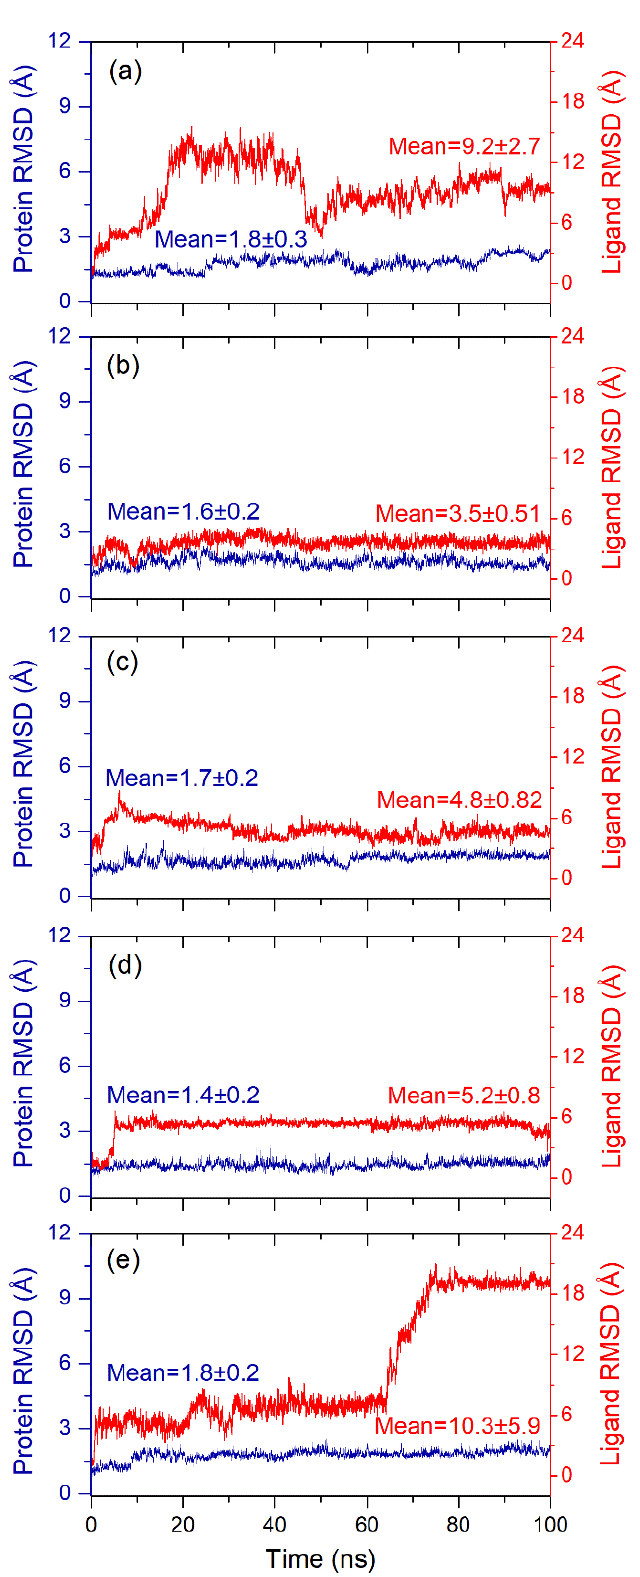
Figure 6. Root mean square deviation ( RMSD) values plotted for alpha carbon atoms (blue curves) of SARS-CoV-2 M pro and natural products (red curves), i.e., ( a ) Echinacoside, ( b ) Quercetagetin 7-glucoside, ( c ) Levan N, ( d ) Inulin from chicory, and ( e ) 1,3-Dicaffeoylquinic acid, were extracted from 100 ns MD simulation interval of respective docked